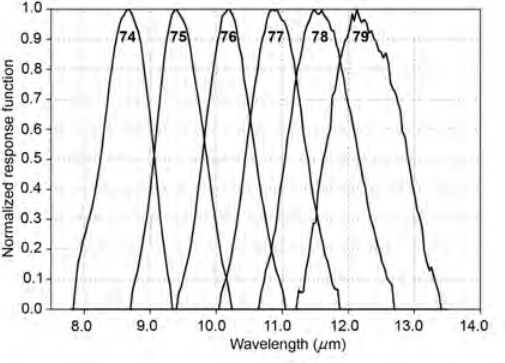
Fig. 4. Response functions of the DAIS thermal in- frared channels.